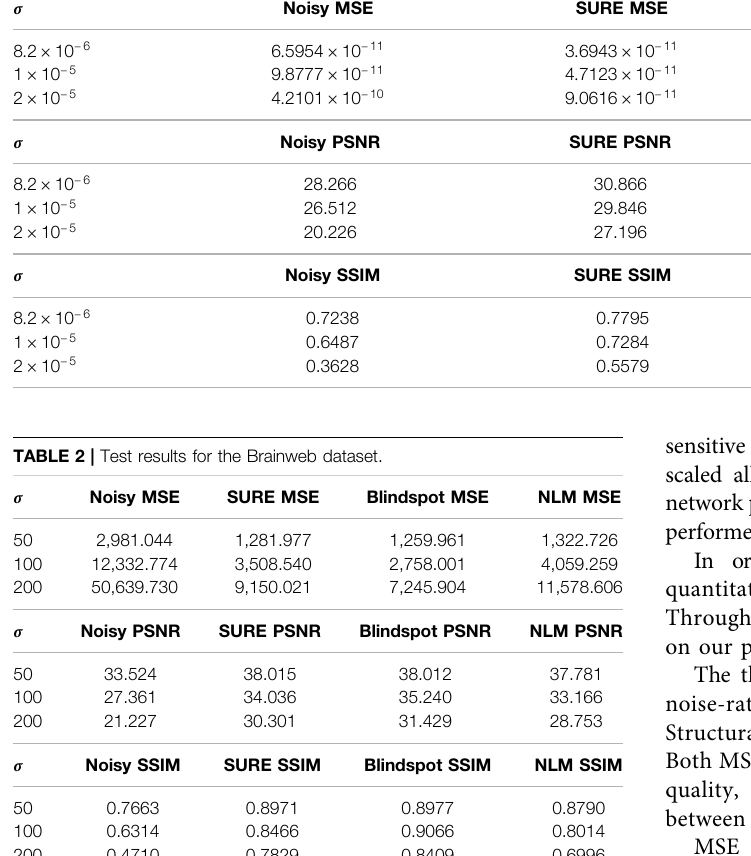
For the Brainweb dataset, we added three different levels of noise. To understand how the networks behave with different levels of noise, we used low level noise with σ (cid:1) 50, middle noise with σ (cid:1) 100 and high level noise with σ (cid:1) 200. In this case, since the data has much bigger values, a higher sigma is used. The three levels of noise can be seen in Figure 3 . Note how the data has to be scaled too, specially for the SURE network, which is highly